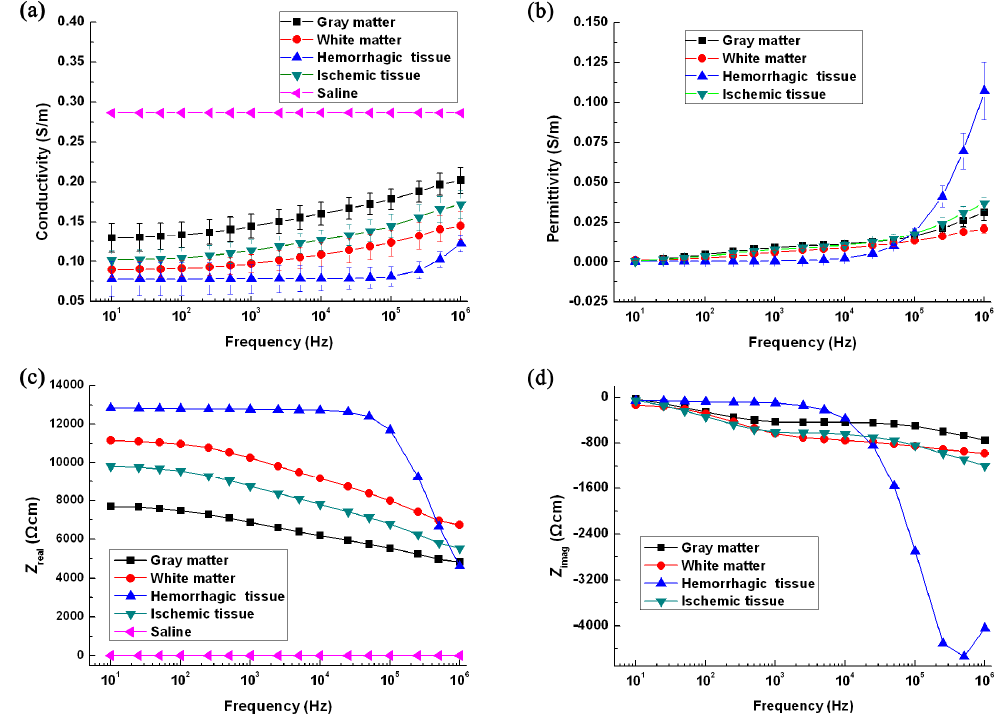
Figure 4. Results of impedance measurement. ( a – d ) The conductivity, additivity and the real and imaginary part of normalized impedance, respectively.